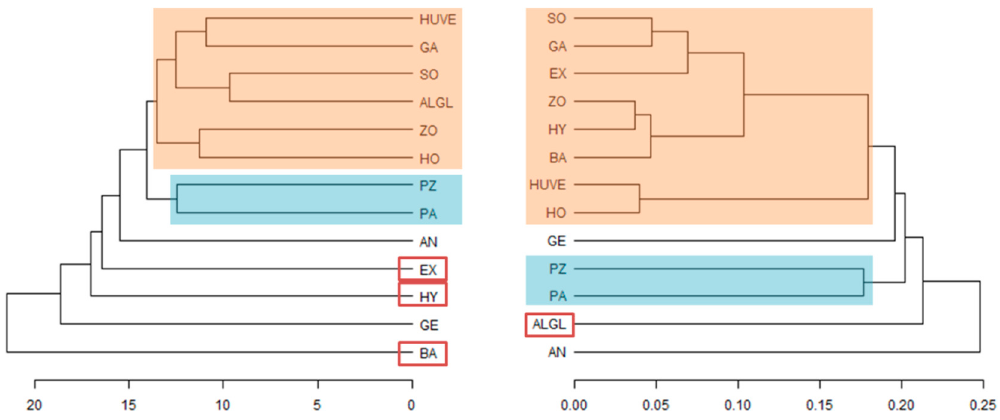
Figure 3. Dendrogram clusters of Mortierella s. l. species based on volatilomes (left) and ITS sequences (right). Clusters were calculated on an average cluster algorithm using median distances of biological replicates. ALGL = M. alpina/globalpina , AN = M. angusta , BA = M. bainieri , EX = L. exigua , GA = L. gamsii , GE = M. gemmifera , HO = P. horticola , HUVE = P. humilis/verticillata , HY = L. hyalina , PA = E. parvispora , PZ = M. pseudozygospora , SO = M. solitaria , ZO = M. zonata . Different colours (blue and pale orange) highlight identical clustering of species, the red rectangles show species with different clustering.